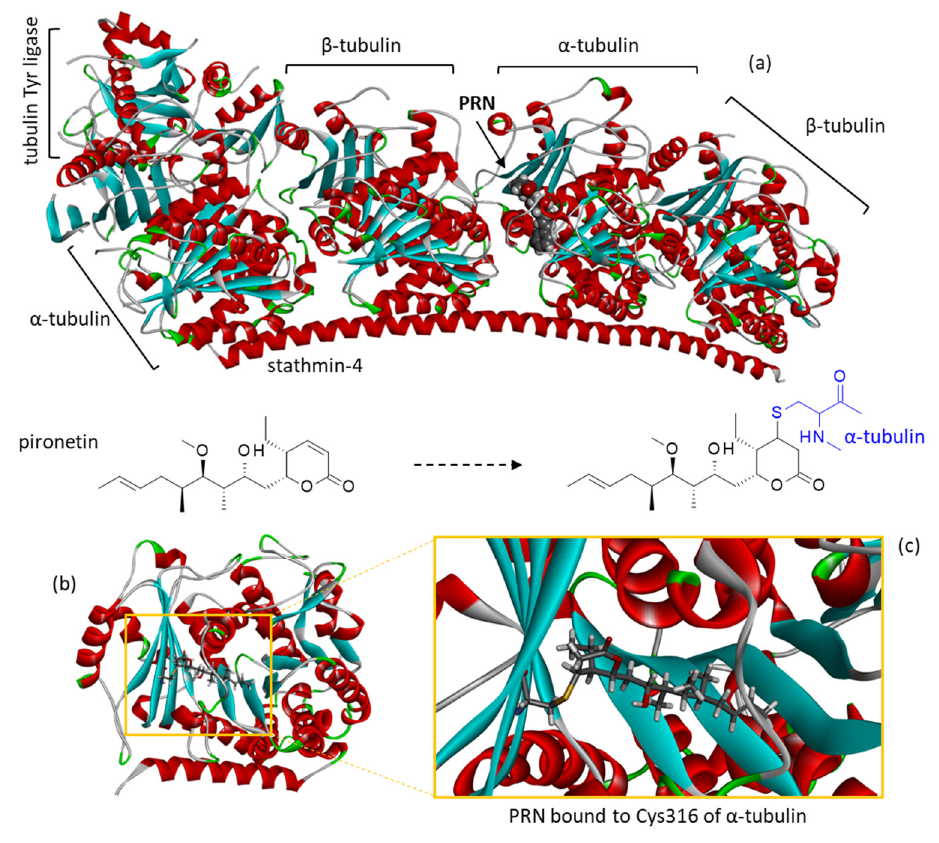
Figure 1. The molecular model of pironetin (PRN) bound to β -tubulin. ( a ) A docking model of PRN binding to the α / β -tubulin dimer interacting with stathmin-4 and tubulin tyrosine ligase (PDB access code: 5FNV) was built. The pironetin active site of α -tubulin is highlighted. ( b ) A close-up view of PRN bound to the active site. ( c ) Detailed view showing the covalent bond between the lactone unit of PRN and the thiol group of Cys316 residue, as indicated on the corresponding structures.